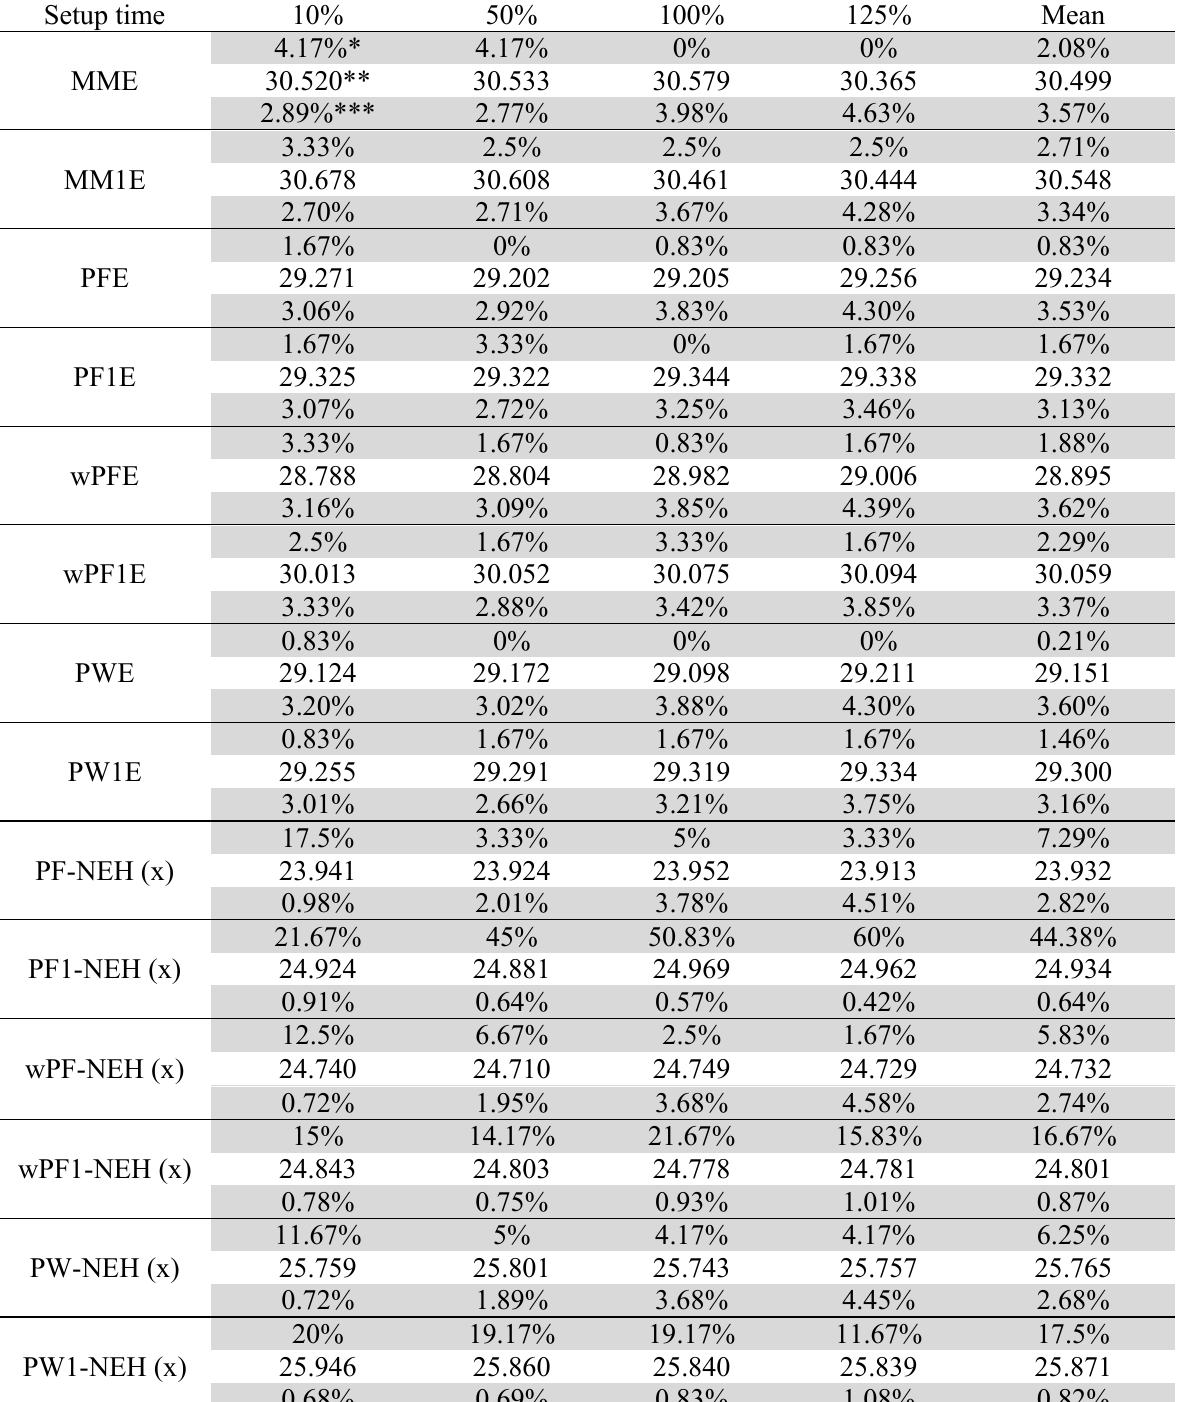
Performance of phase II